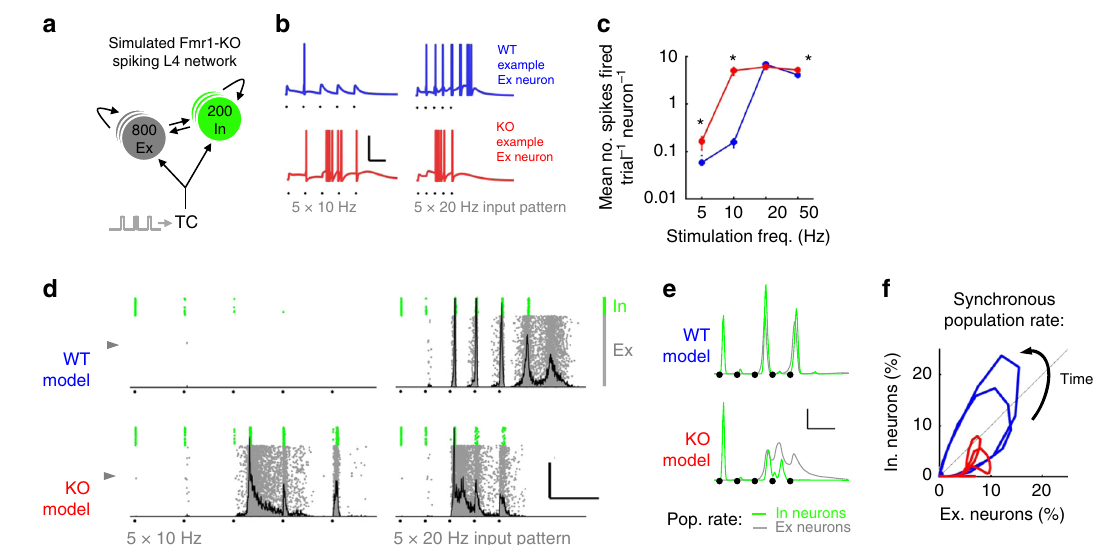
Fig. 9 A Fmr1-KO layer 4 model reproduces features of the network response to TC input. a Schematic of model circuit comprising recurrently connected pools of Ex and In neurons receiving simulated thalamocortical input. b Simulated membrane potential for two example Ex neurons (indicated by grey arrowheads in ( d )) for TC input at 10 and 20 Hz stimulation frequency. Black dots indicate stimulus times. Scale: 100 ms/50 mV. c Frequency-dependent spike output of model Ex neurons. Asterisks denote signi fi cantly different spike mean spike counts between models ( p < 0.05, t -test, 800 neurons per model, 5 random models, average of 10 trials each). d Exemplar full network spike rasters for Ex and In neurons (grey and green, respectively) showing fi ring patterns in response to 5 × 10 – 20 Hz model thalamocortical stimuli. Population histograms of Ex neurons overlaid in grey. Scale: 100 ms, 50% Synchrony. e Grand mean Ex (grey) and In (green) population spike density functions (5 random seeds, 10 repeats each) from Fmr1 + /Y and Fmr1 − /Y simulations. Note impaired E – I population interaction in Fmr1-KO simulations. f Phase plot summarizing rhythmic Ex – In population interaction in Fmr1 + /Y and Fmr1 − /Y models. Note reduced global synchrony and impaired recruitment of Inhibitory neurons in Fmr1 − /Y